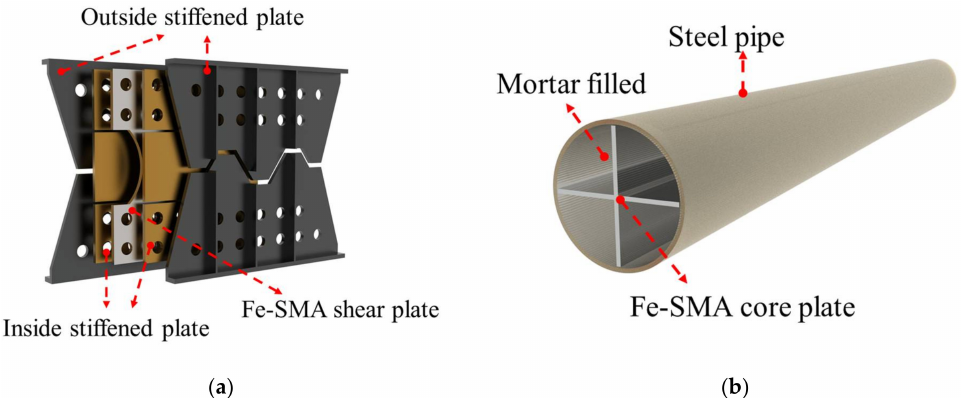
Figure 16. Configuration of Fe-SMA-based ( a ) BRS; and ( b ) BRB developed by a Japanese industry– academic–government joint research group.